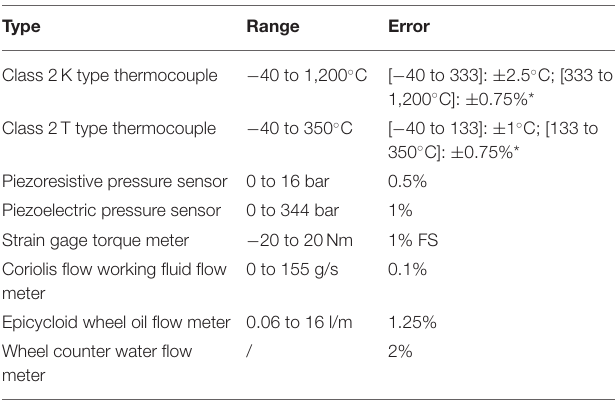
TABLE 2 | Sensors characteristics and location.